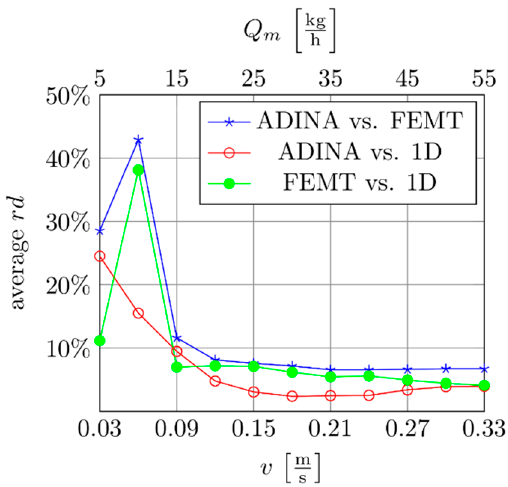
Figure 11. The average values of relative differences of the heat transfer coefficient obtained using different approaches: ADINA software, FEMT and 1D approach versus flow rate Q m